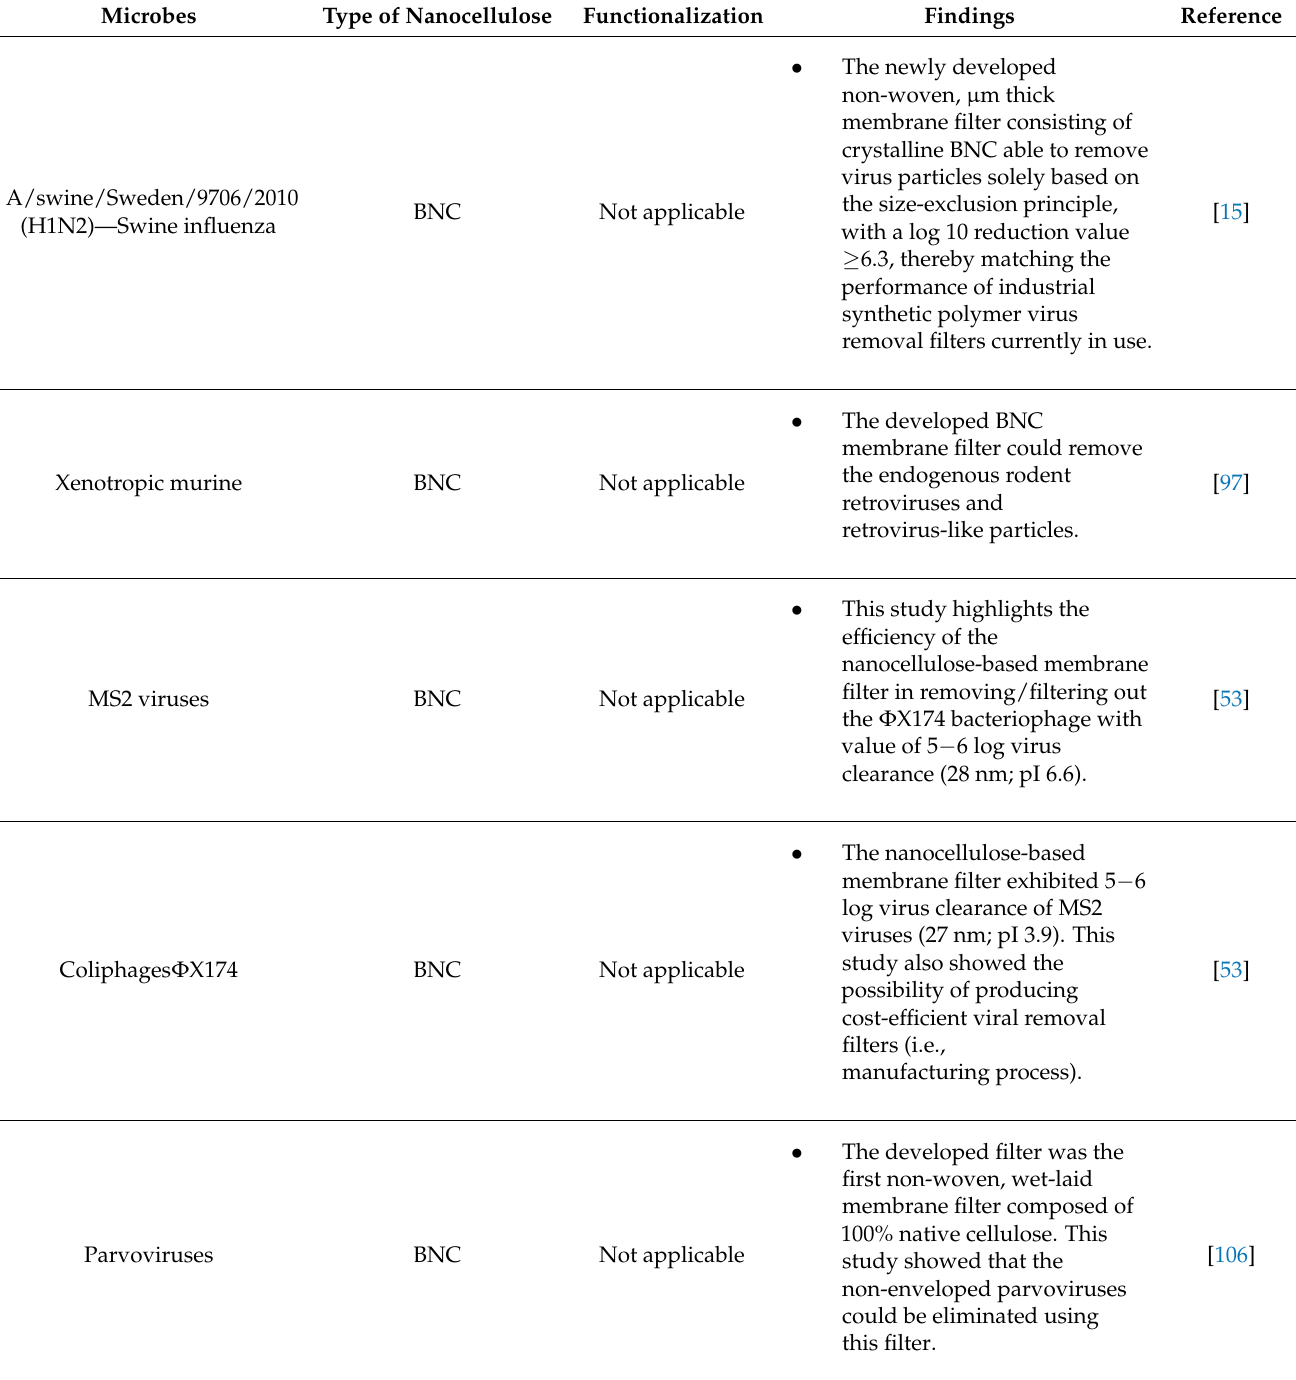
Table 7. Nanocellulose developed filtration material for virus